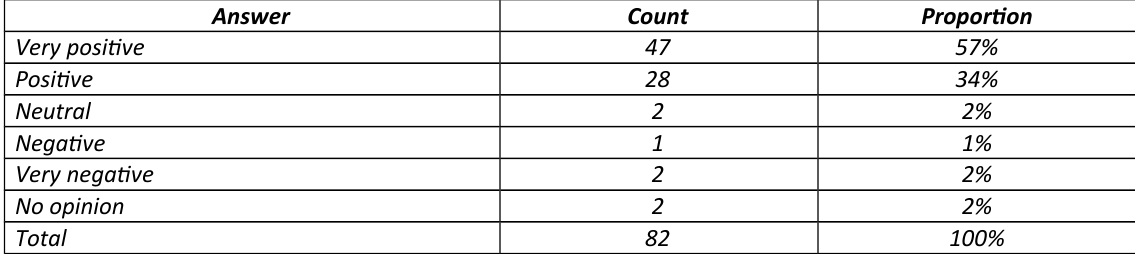
Table 1. Queston 1: What is your percepton about the use of the graphics tablet by your instructor, regarding